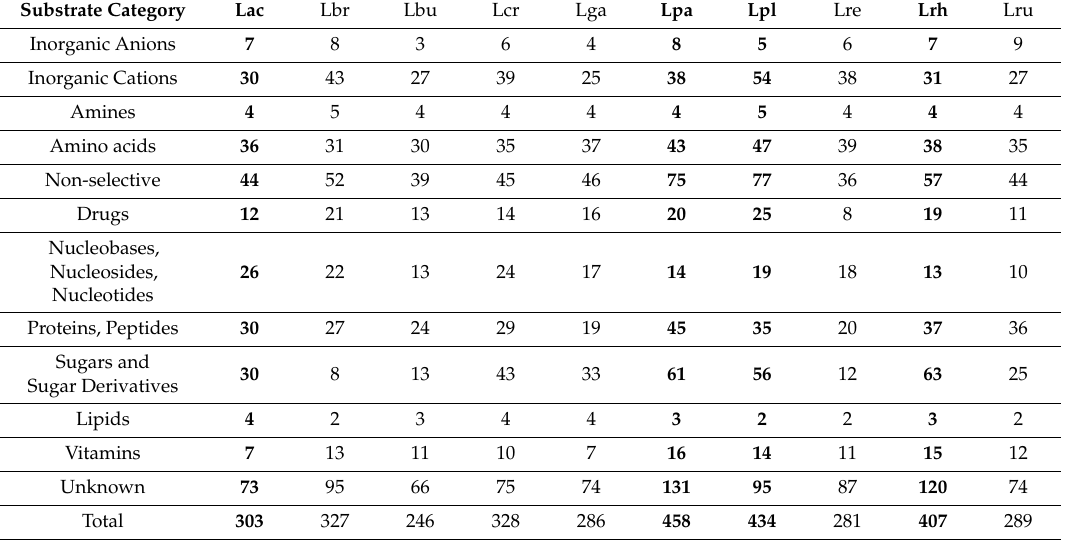
Table 4. Overview of predicted substrate specificities of transport proteins (expressed in numbers) in the ten Lactobacillus strains. The PAP strains are in